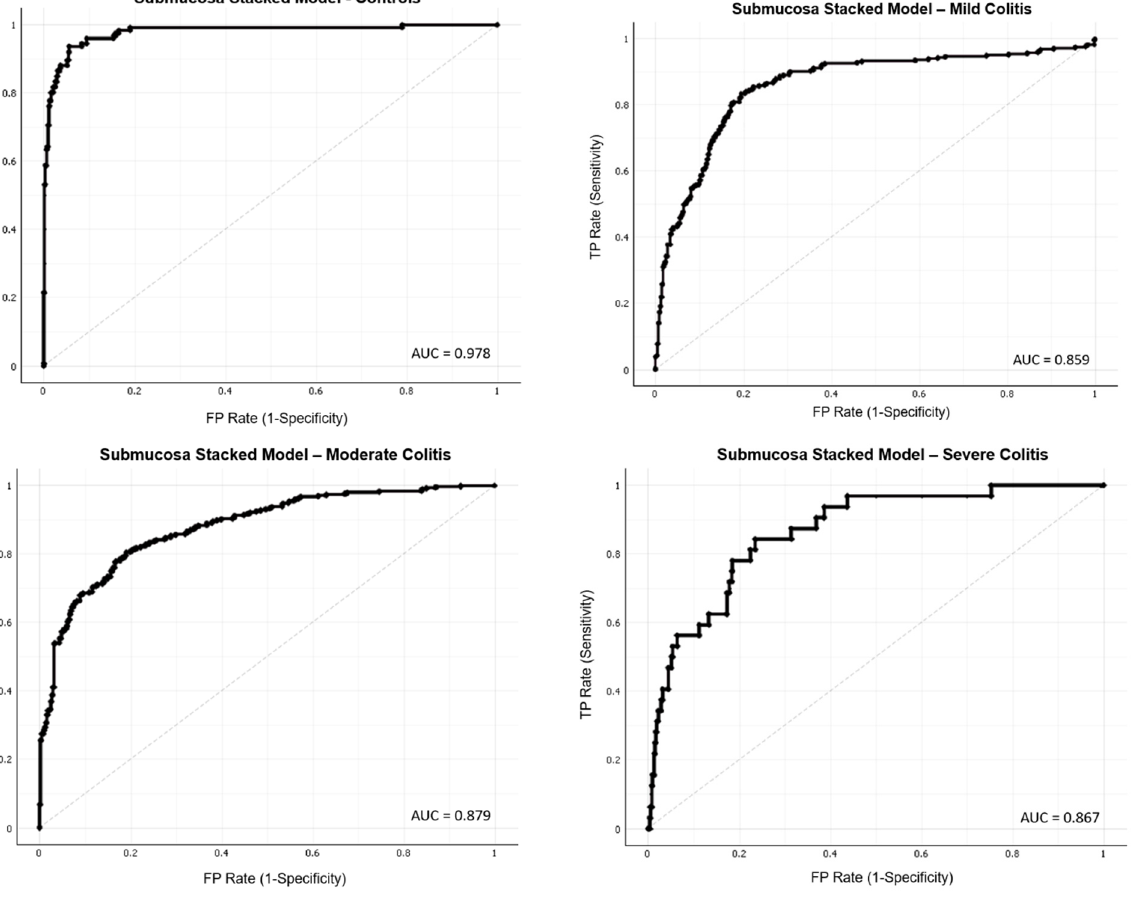
Figure 8. ROC and AUROC for stacked model classification performance according to colitis severity using submucosal spectra and validated by independent test sets. See Scheme 1 for more details.